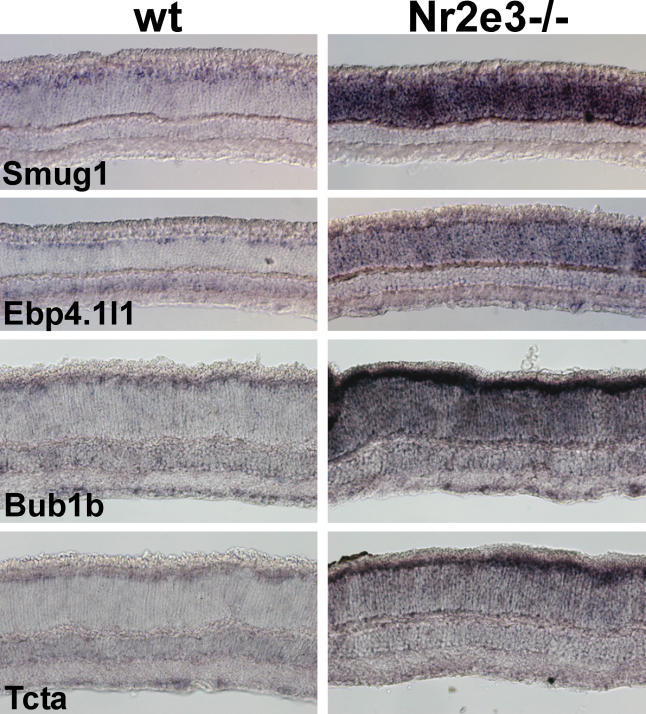
Expression Patterns of Several Novel Cone Genes Up-Regulated in rd7
In the wild-type images (wt), note the scattered, weakly positive cells at the scleral edge of the outer nuclear layer in a cone distribution. All of the genes show marked up-regulation in the rd7 mutant. Bub1b and Tcta show transcript localization predominantly to the inner segment of the photoreceptors. Retinas are oriented such that the scleral edge is up.